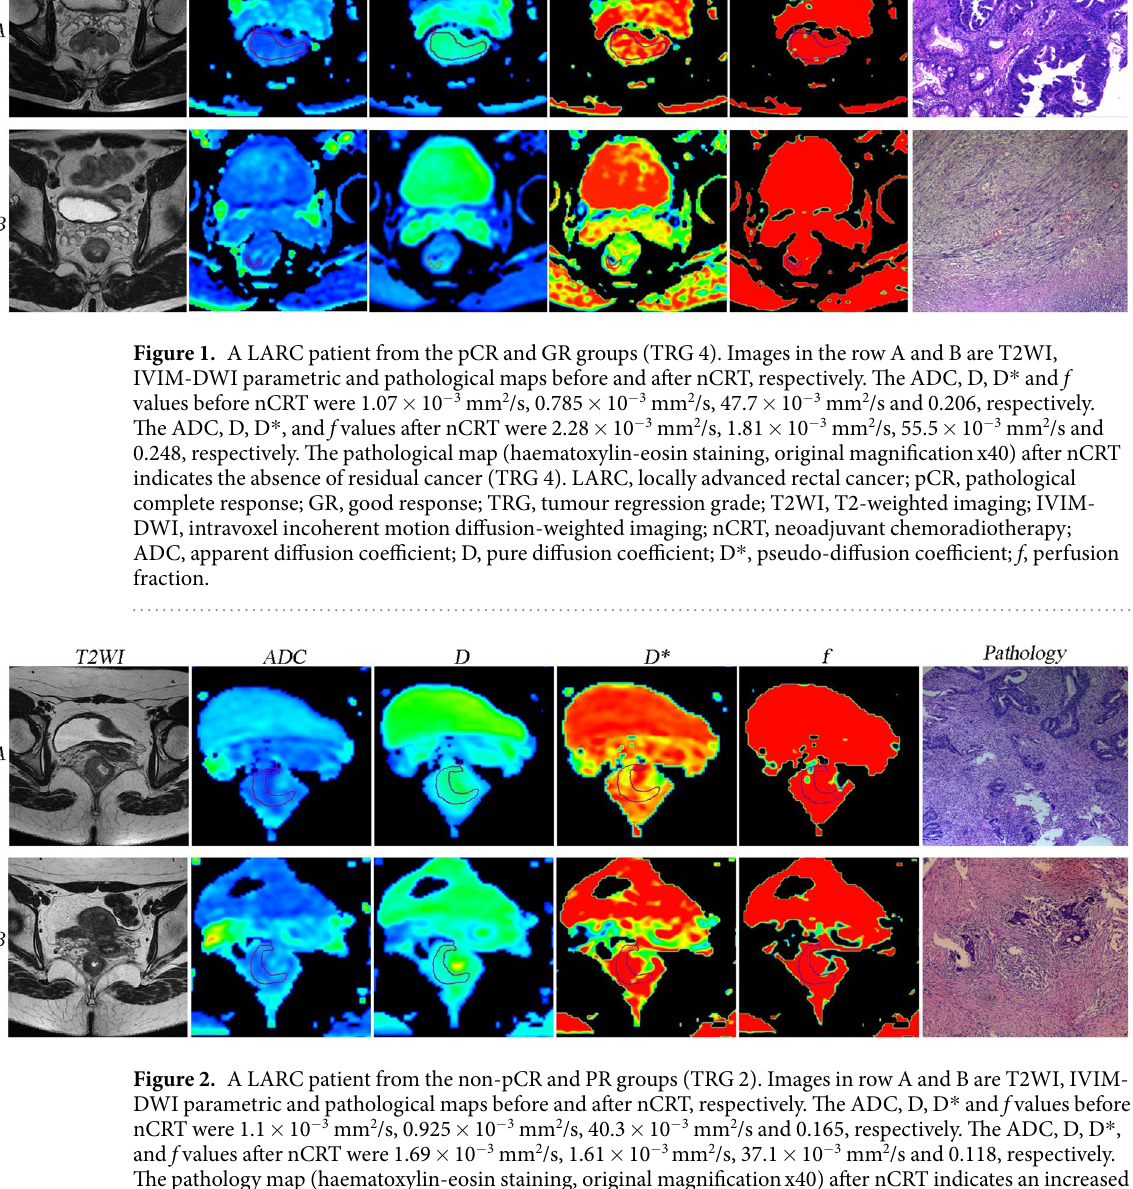
that the diffusion-related microenvironment in LARC after nCRT has significant relevance to the status of the residual tumour. This suggestion was also supported by our observation that there were obviously higher postD, ∆ %ADC and ∆ %D values for the pCR ( versus non-pCR) groups. Prior studies on rectal cancer also revealed a significant addition of postD and/or ∆ %ADC values for LARC after nCRT 5–7, 9, 12 . These findings indicate that the pure diffusion parametric values after nCRT may play an important and reliable role in noninvasively identifying a pCR response for LARC preoperatively. In this study, the pCR group exhibited significantly higher preD * and pre f values than the non-pCR group. Additionally, the TRG score revealed a positive correlation with pre f . These findings indicate that higher micro- circulatory perfusion at baseline might result in better sensitivity to nCRT for LARC. Several previous studies 25–27 using DCE-MRI also demonstrated that rectal cancer with higher pre-nCRT perfusion will respond favourably